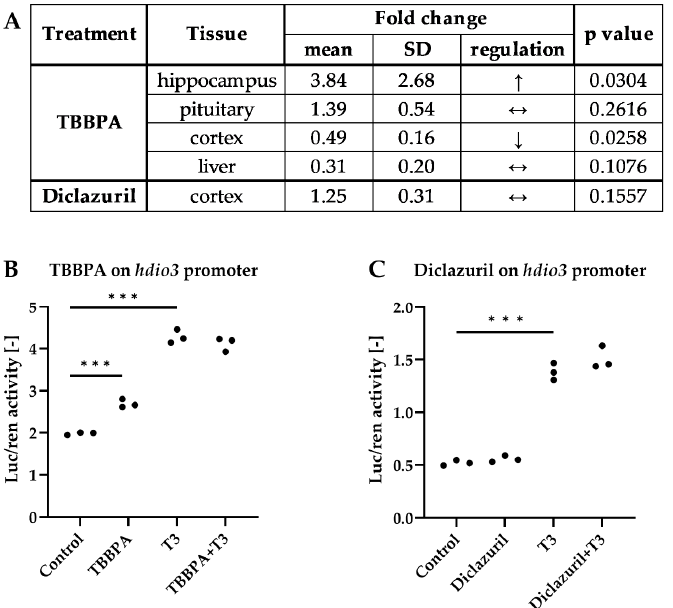
Figure 7. Regulation of dio3 expression by TBBPA and diclazuril. ( A ) of dio3 mRNA changes in different tissues of male THAI mice treated orally for 6 days with 150 mg/bwkg/day of TBBPA in corn oil containing 2% Et-OH or for 5 days with 10 mg/bwkg/day of diclazuril as a saline suspension; ( B , C ) transfected HEK293T cultures treated with 50 nM T3 and/or 1 μ M TBBPA or diclazuril measured with Dual-Luciferase Reporter Assay. n = 4–6 mice/group for A, α = 0.05; ***: p < 0.001. To understand whether these were indirect, compensatory changes or direct effects of TBBPA on the dio3 promoter, we performed promoter assays in HEK293T cell cultures transfected with a luciferase reporter linked to a dio3 promoter, which enabled the biolu- minescent quantitation of promoter activity. TBBPA increased dio3 - luciferase expression in hormone-free medium and did not have an additive effect in the presence of 50 nM T3, that, as expected, also induced reporter expression in the presence of TR β (Figure 7B). In contrast, diclazuril did not regulate dio3 promoter activity either in the cerebral cortex or in the in vitro promoter assay (Figure 7A,C). Interestingly, TBBPA is likely able to impact the local TH action in various tissues by directly interacting with the dio3 promoter, but this effect seems to be insufficient to alter cortical TH action, as shown by the unaltered luciferase mRNA level.